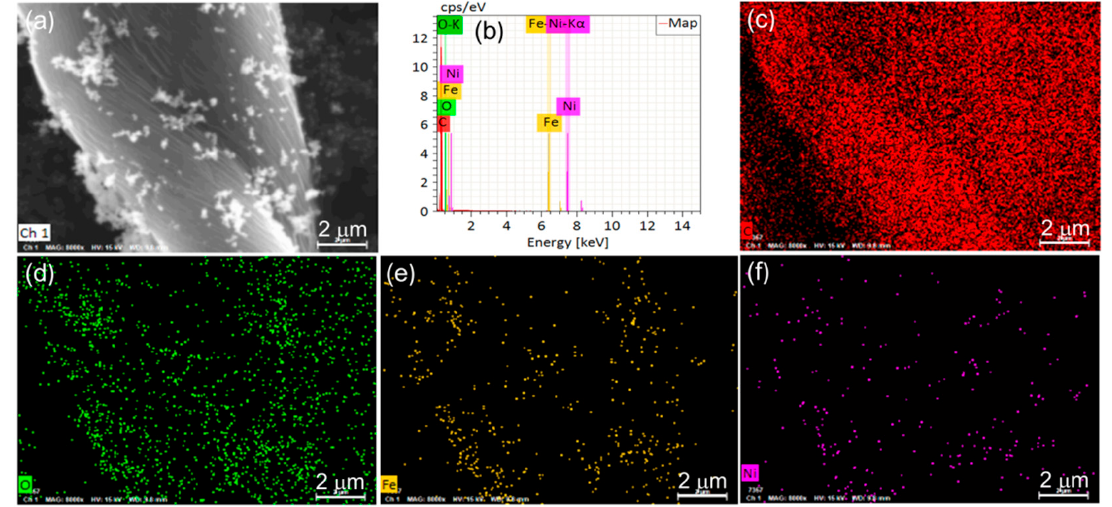
Figure 3. ( a ) SEM image, ( b ) EDX spectra, and ( c – f ) elemental mapping images of NiFe 2 O 4 /CCF-2.